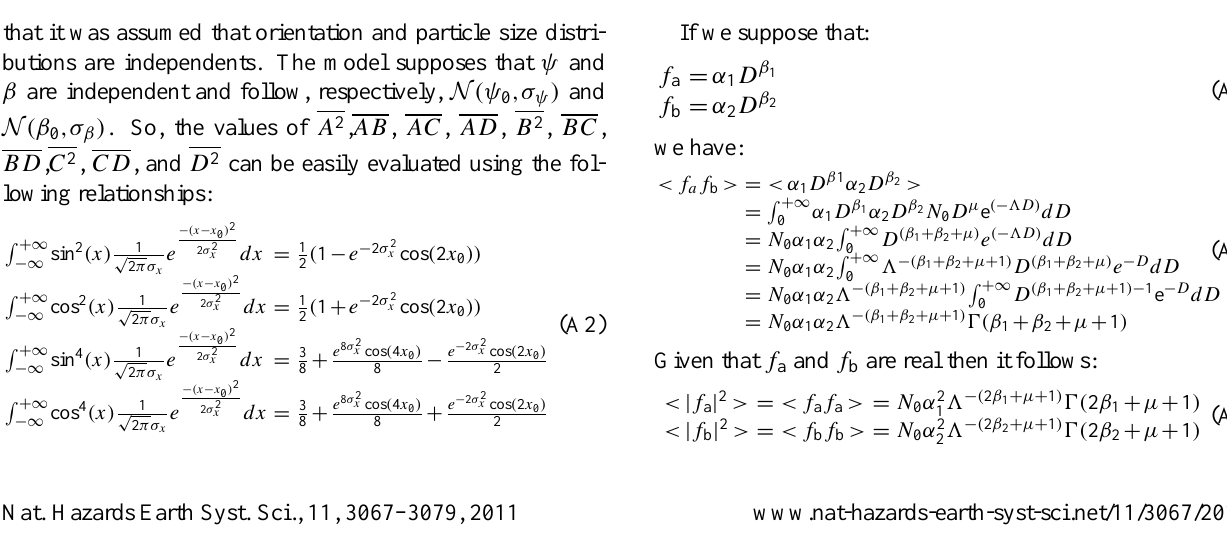
Fig. 8. Standard deviations, considered from Bringi and Chandrasekar (2001) (a) R(Z) , (b) R(K dp ) , (c) R(Z,Z dr ) , (d) R(K dp ,Z dr ) , and for the proposed algorithm (e) R(Z,K dp ,Z dr )